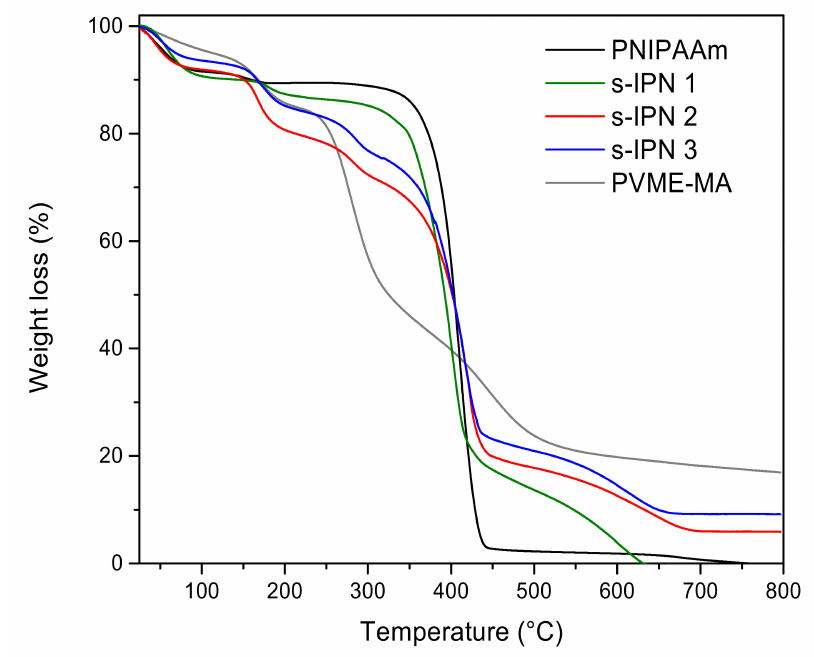
Figure 4. Thermograms of neat PNIPAAm hydrogel, PMVE-MA, and s-IPN